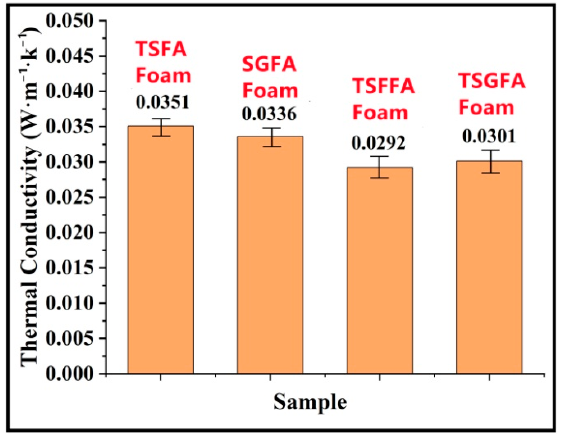
Figure 5. Thermal conductivity values of the various foams.